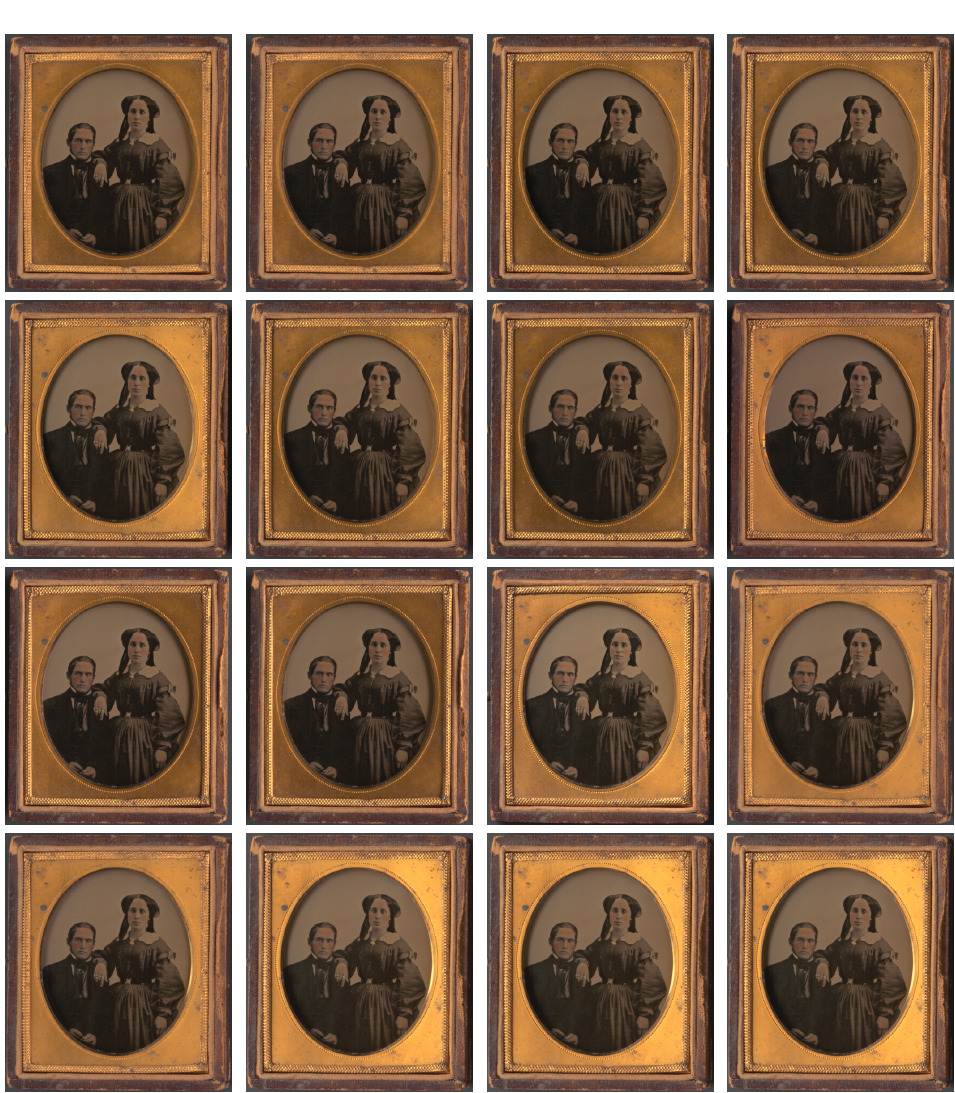
Figure A1. Images of ambrotypes scanned with different light modes. From left to right: LRFB , LR